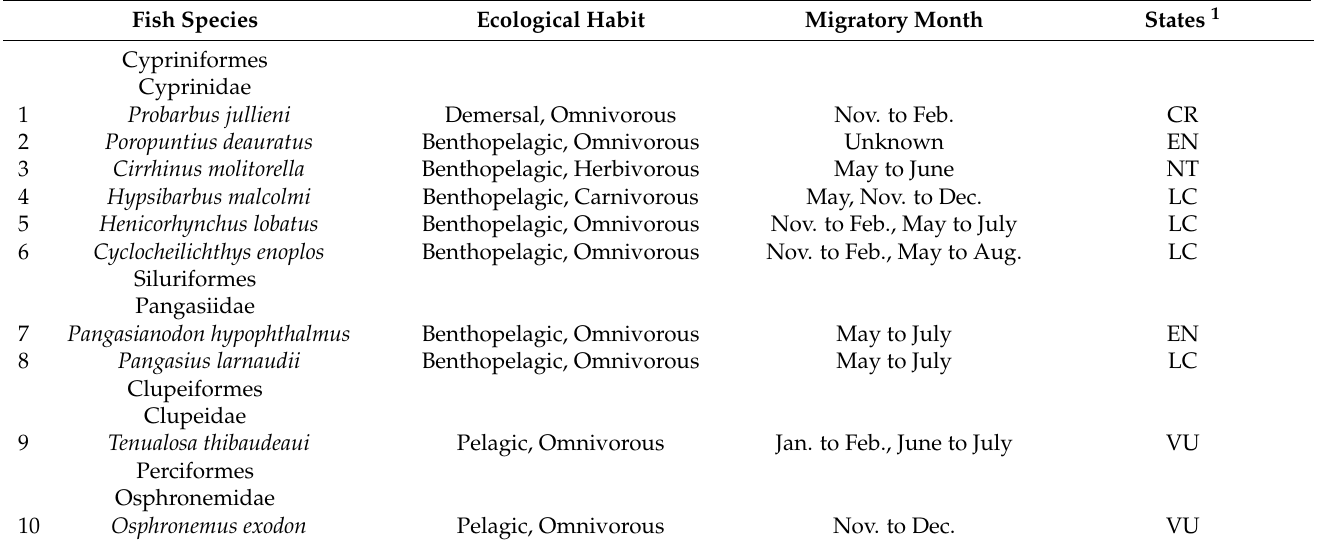
Table 1. Information on the target migratory fish species of the